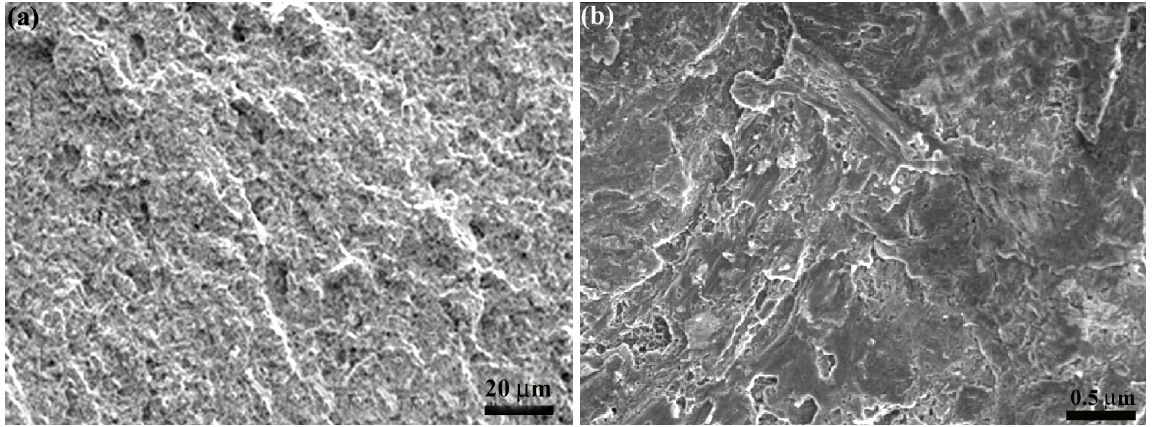
Figure 10. Fractography analysis of the tensile tested joints of the failure location ( a ) 42CrMo4 and ( b ) 18Cr-8Ni.